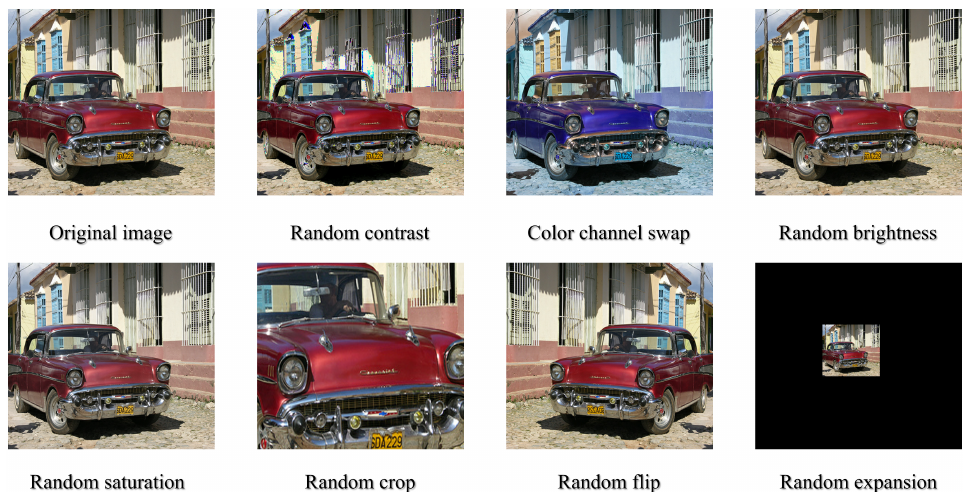
Figure 5. An example of the data augmentation used in the